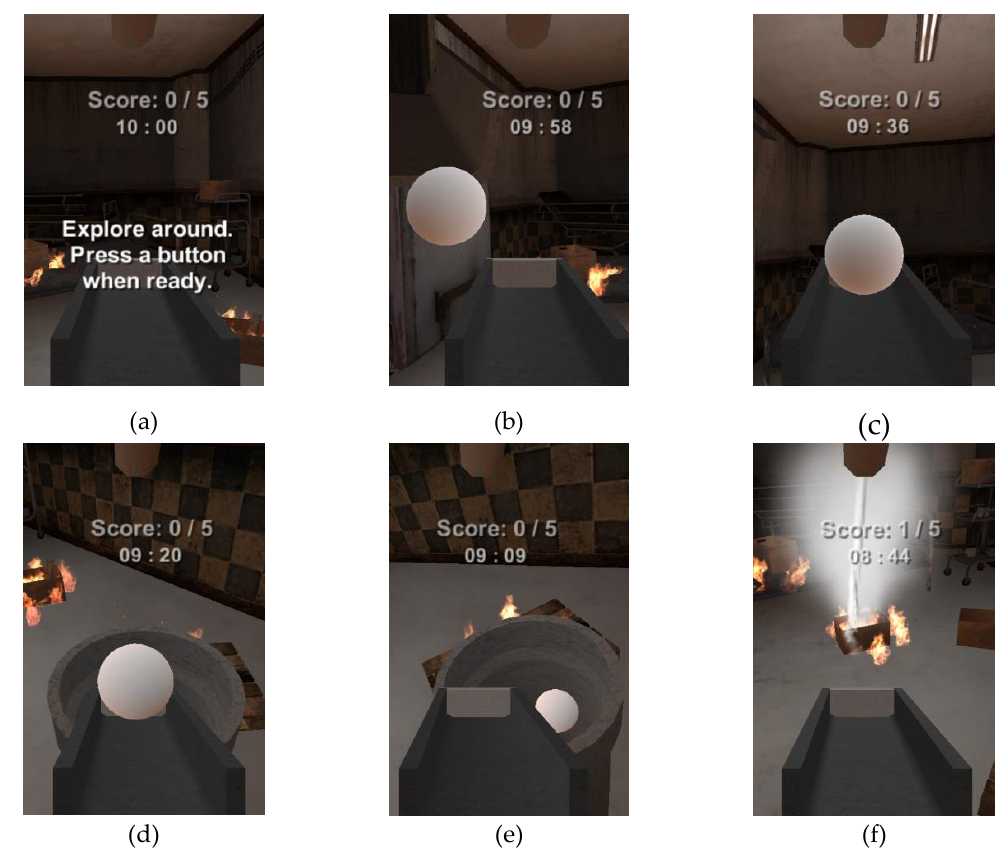
Figure 1. Screenshots from the game Room on Fire . ( a ) The player is permitted to observe the virtual environment until a button is pressed, starting the game. ( b ) The player turns left to receive a ball from the dispenser. ( c ) The player carries the ball. ( d ) The player transfers the ball to the target container on the right. ( e ) The ball enters the target container. ( f ) The water pipe dispenses water, allowing the player to extinguish a fire.